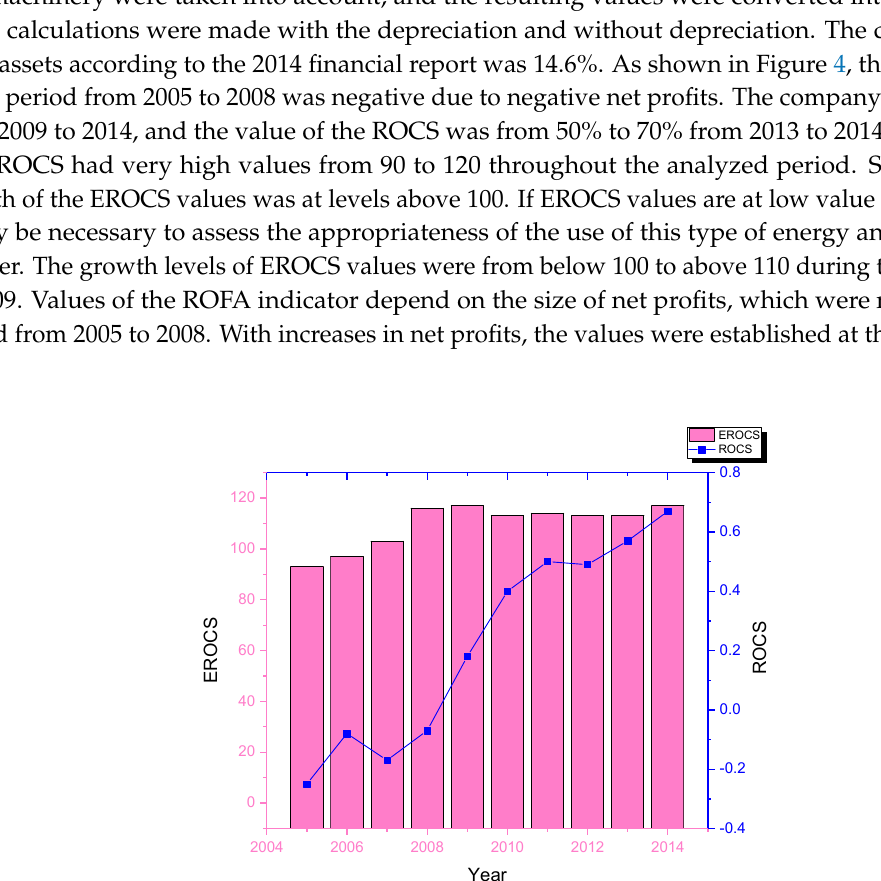
Figure 5. Dynamics of indicators of ROFA. Table 4. The converted data and the EROFA value in 2014. Name